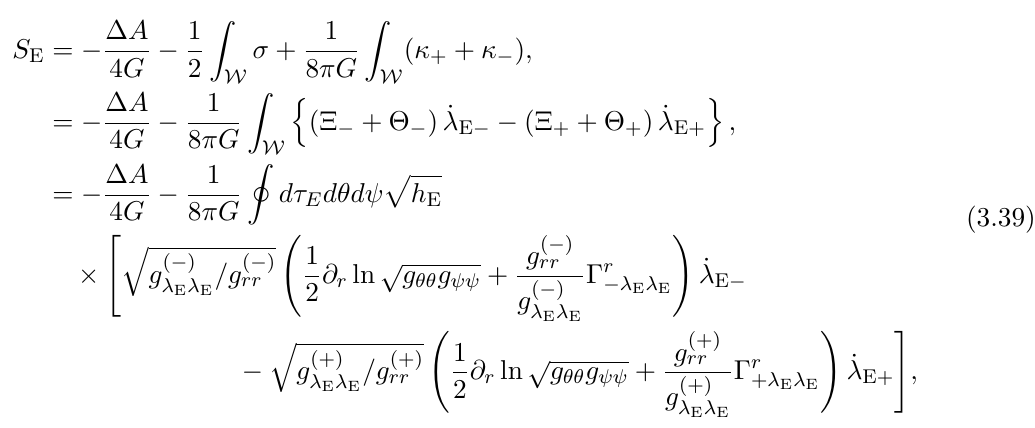
JHEP01(2020)015